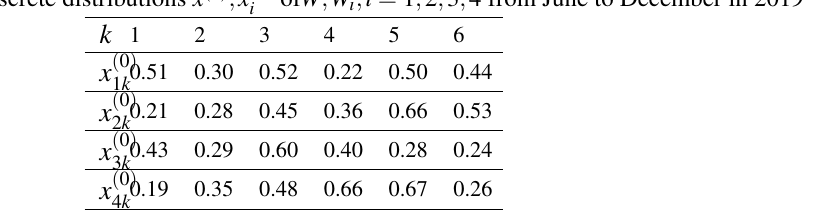
Table 1 The profit discrete distributions x ( 0 ) , x ( 0 )